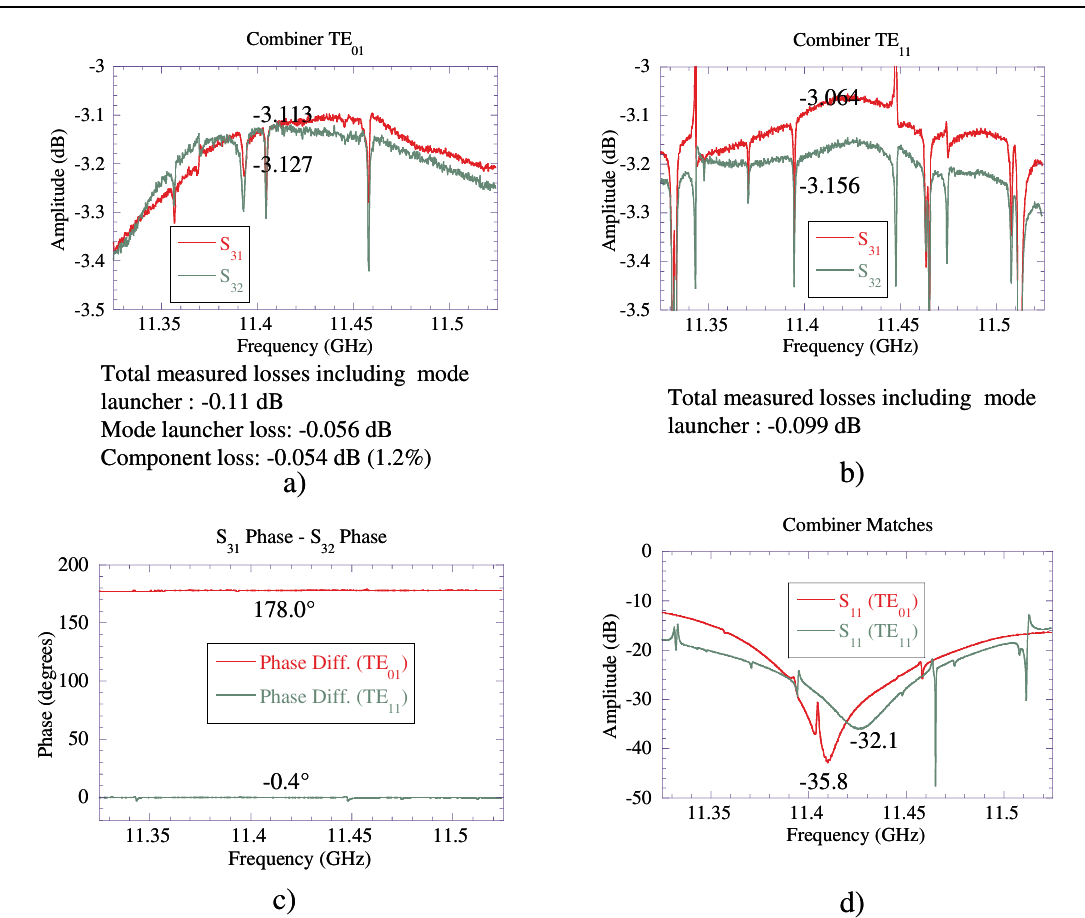
FIG. 8. (Color) Cold test results of the dual-mode combiner. The port indexing (scattering parameter subscripts) is in reference to Fig. 7. All measurements include the response of a cold test circular mode